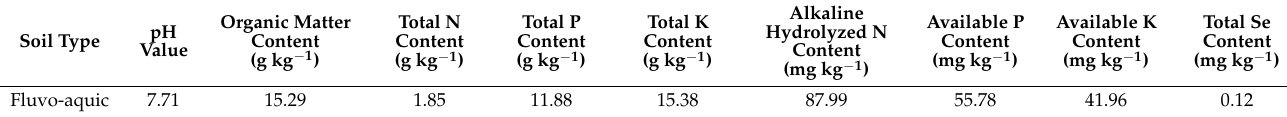
Table 7. The basic chemical properties of